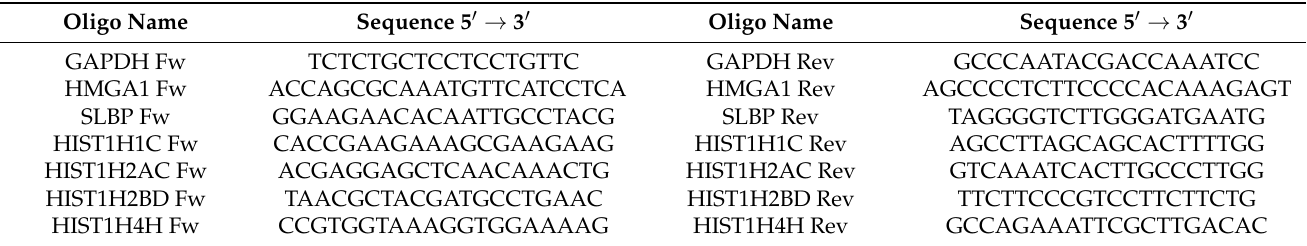
Table 1. List of primers employed for